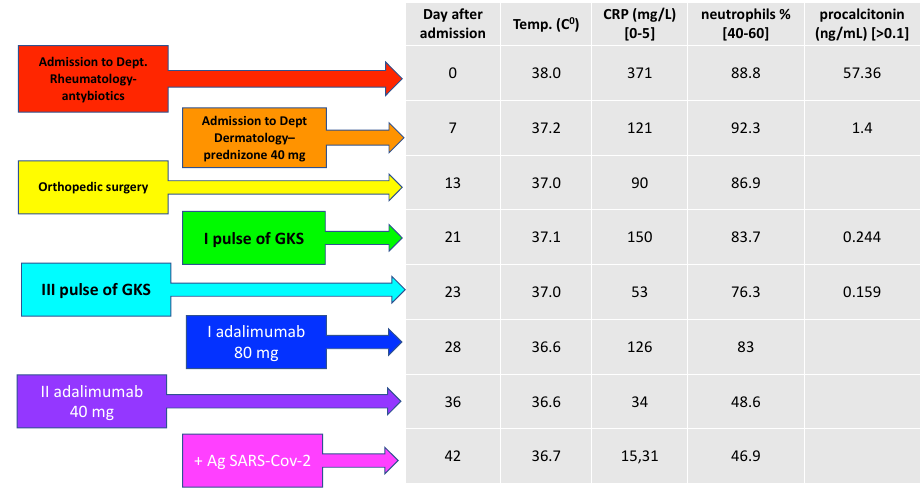
skin loss with Optilene mesh. The procedure was performed due to purulent inflamma-